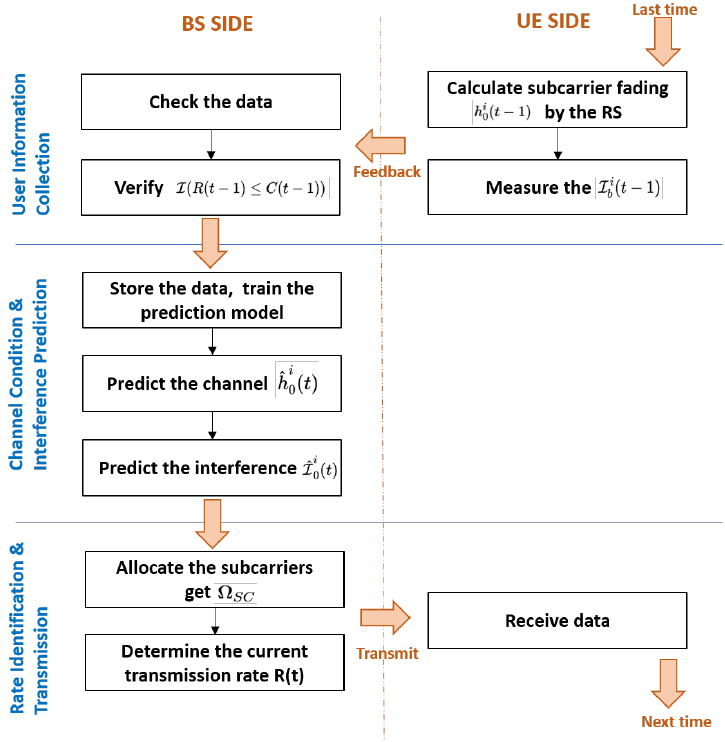
Figure 2. Every time slot downlink data transmit process flow